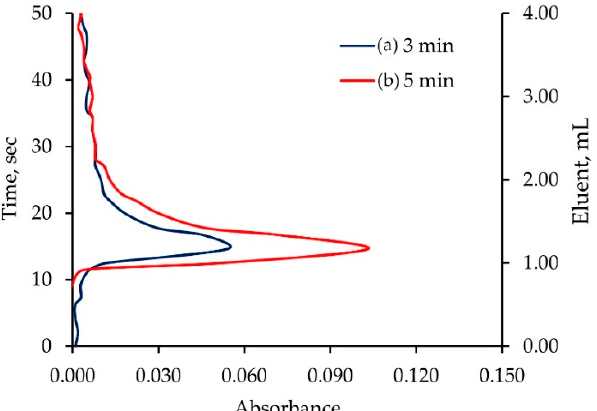
Figure 2. Elution profiles of loaded Pb 2+ on the monolithic ALG-PUC in-valve column situated in FI set up: (a) 3 min and (b) 5 min loading time.